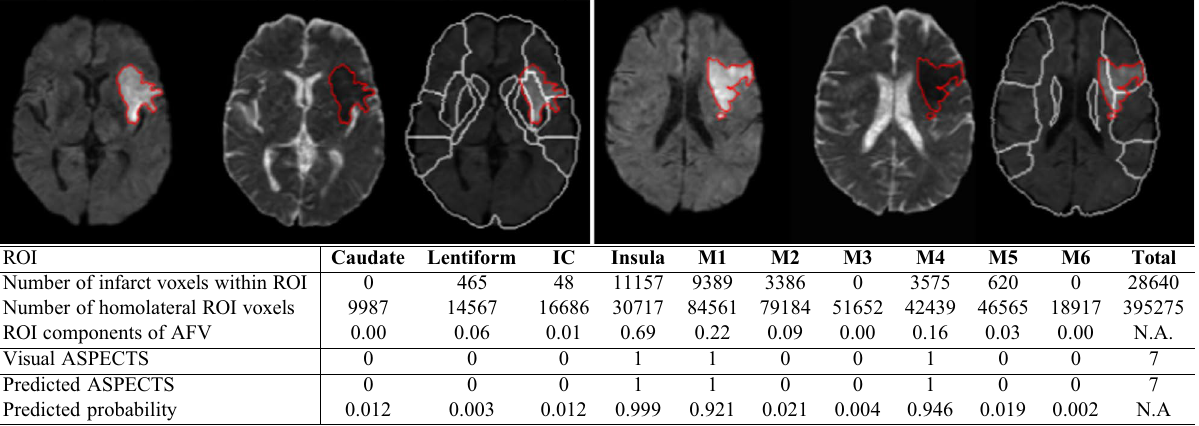
Figure 3. Example of ASPECTS feature vector (AFV) calculation. Each AFV component represents the percentage of the ASPECTS ROI affected by the infarct (number of voxels in which the infarct mask = 1/ total number of voxels within the respective bilateral ROIs). The “visual ASPECTS” row shows the ASPECTS according consensus human evaluation, which is here considered the gold standard. The bottom two rows show the ASPECTS predicted by ML and the predicted probability, which are outputs of our automated tool,